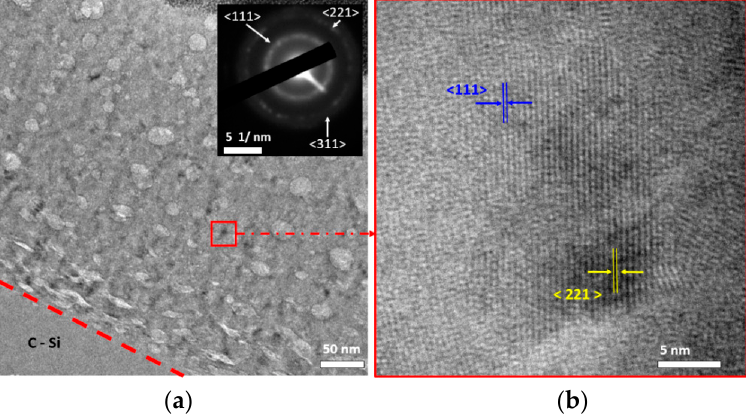
Figure 2. Transmission electron microscopy (TEM) micrograph of nanocrystalline grains as prepared ( R = 40) ( a ) and the related diffraction patterns (inset) ( b ).